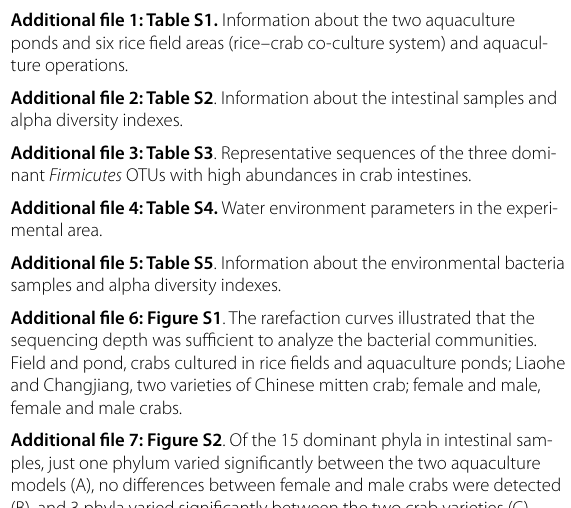
Additional file 9: Figure S4 . The Spearman correlation heatmap shows the correlation between the 50 dominant Firmicutes OTUs and body parameters of sampled crabs. OTU2976 was negatively related to body length, width, and weight of sampled crabs. Positive correlations